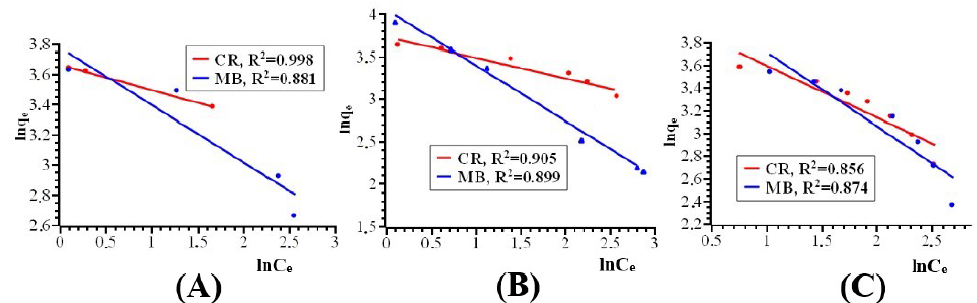
Figure 10. Freundlich isotherms in linearized form at 283 ( A ), 291 ( B ), and 308 K ( C ).